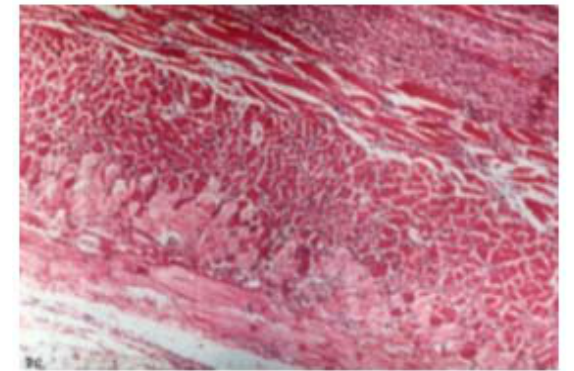
FIGURE 3 - Microscopic view of esophageal mucosa: edema and neutrophylic inflammation (NaOH solution 4%)